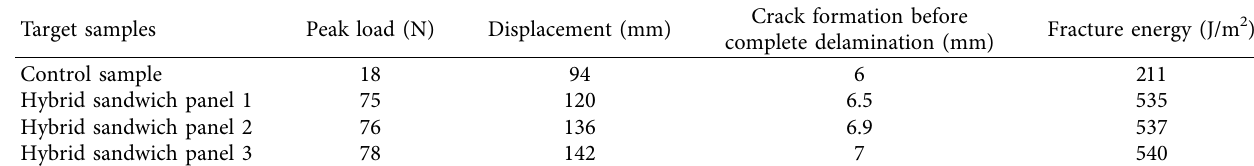
Figure 6: (a) Load vs. displacement curve for hybrid sandwich panels, (b) peel test setup in universal testing machine, and (c) schematic representation of peel test sample. Table 4: T-peel experimental test